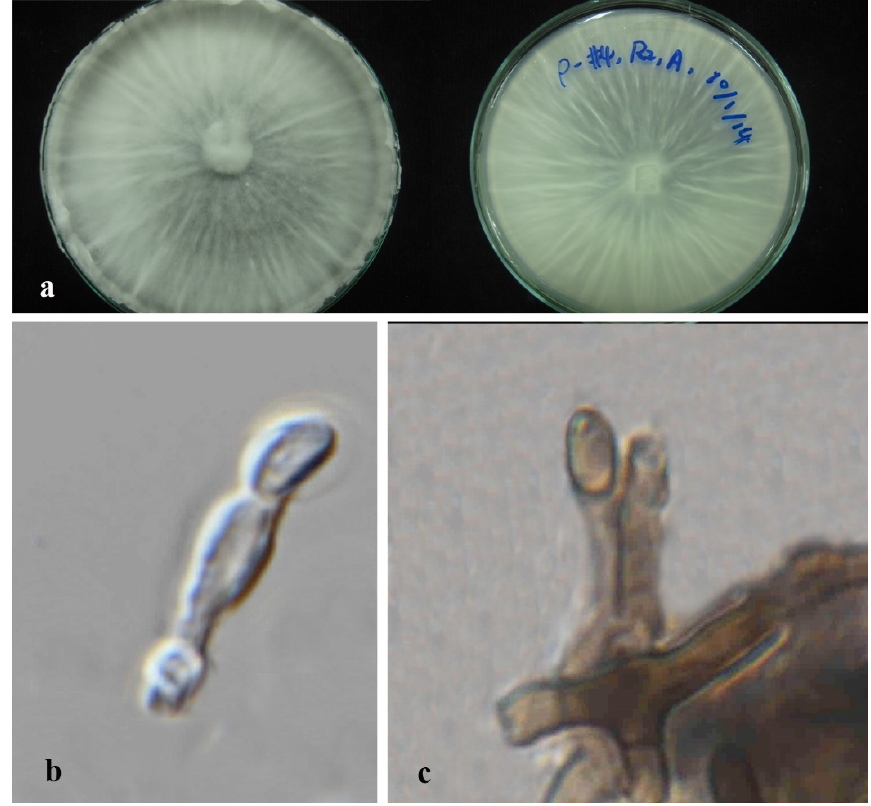
Figure 13. Nemania diffusa (MFLUCC 14-0139) ( a ) Colony on PDA (left-front view, right-reverse view). ( b , c ) Conidiophores with conidia-like structures. ( b , c ) Conidiophores with conidia-like